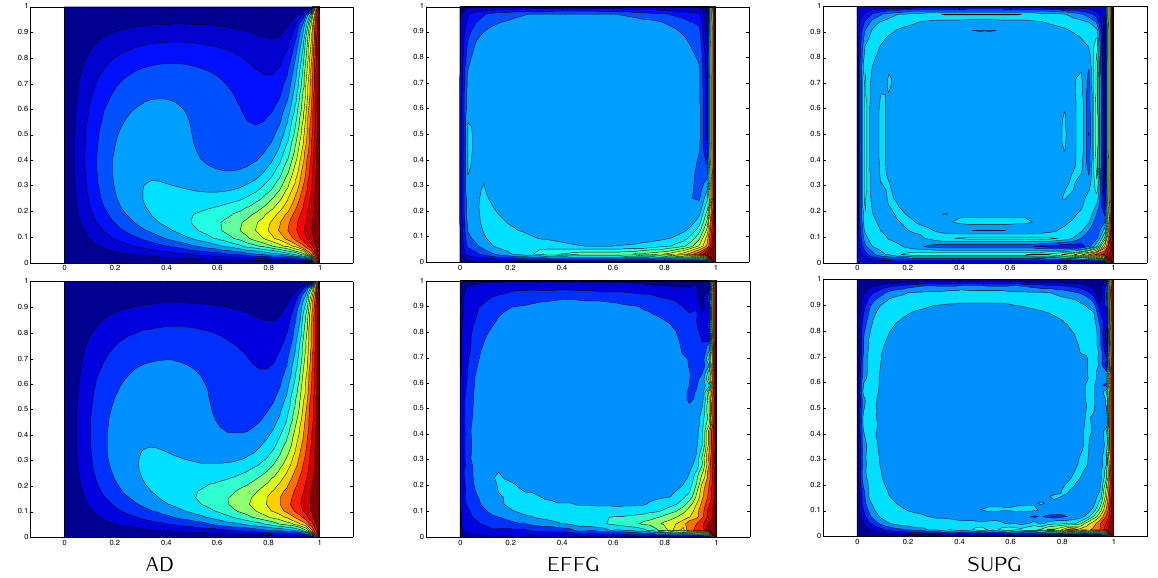
Figure 8. Solution of the double glazing test problem (31) with ε = 0 . 00001 by AD (left) vs. EFFG (middle) and SUPG (right) on 33 × 33 grids. Top row: uniform grid. Bottom row: randomly perturbed grid.